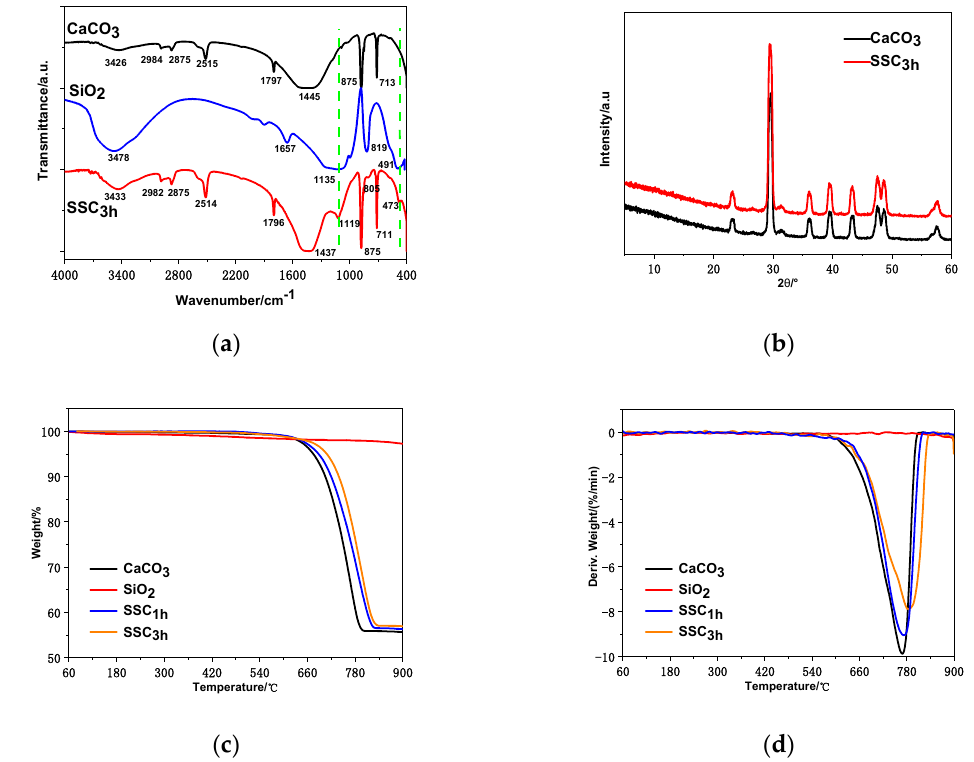
Figure 2. ( a ) FTIR spectrum of SiO 2 , CaCO 3 and SSC 3h ; ( b ) XRD spectra of CaCO 3 and SSC 3h ; ( c ) TGA curves of SiO 2 , CaCO 3 , SSC 1h and SSC 3h ; and ( d ) DTGA curves of SiO 2 , CaCO 3 , SSC 1h and SSC 3h .